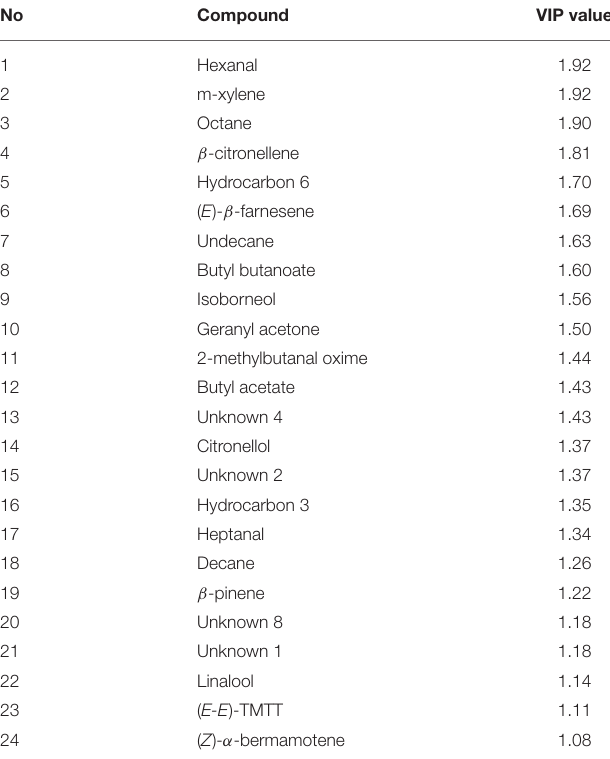
TABLE 3 | Variable importance to the projection (VIP) of volatiles for the corresponding PLS-DA plots, with value more than 1.0, which can be chosen as the characteristic volatile compounds for the differentiation between